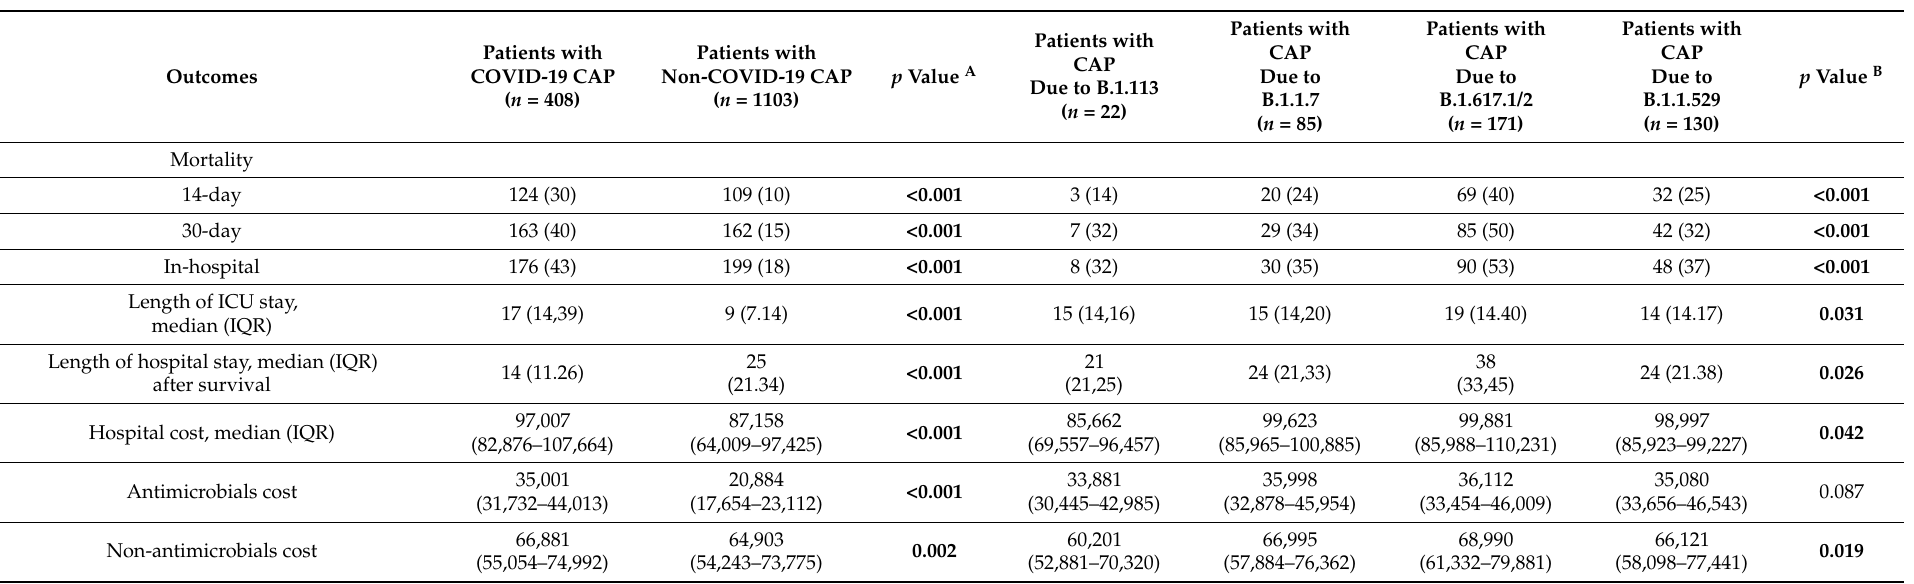
Table 4. Comparisons of outcomes of patients with community-acquired pneumonia (CAP) due to coronavirus disease 2019 (COVID-19) and non-COVID-19 CAP and comparisons of outcomes among the patients with CAP due to the B.1.113, B.1.1.7, B.1.617.1/2 and B.1.1.529